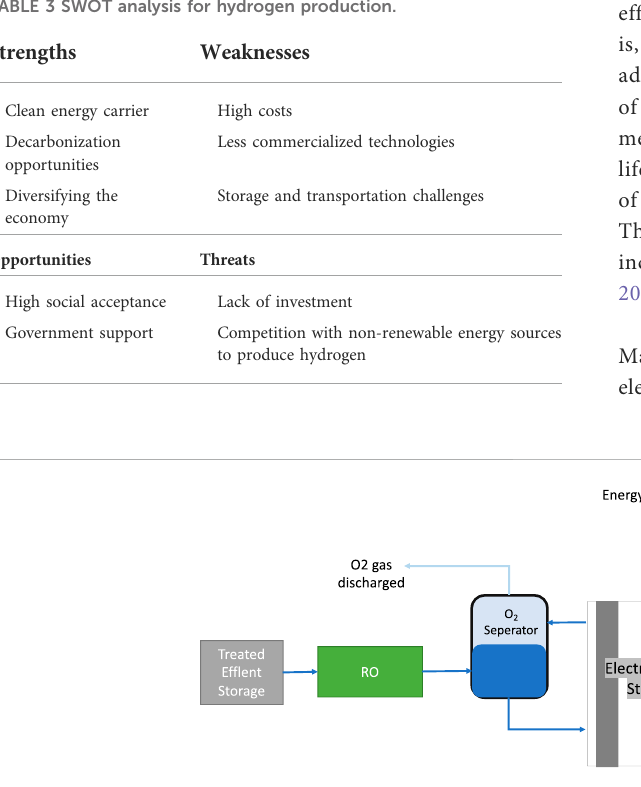
Table 3 represents the loading and concentration of the TE as data provided by the company for Al Ansab STP, taking TE as a source of water that gets transported to the electrolysis system.